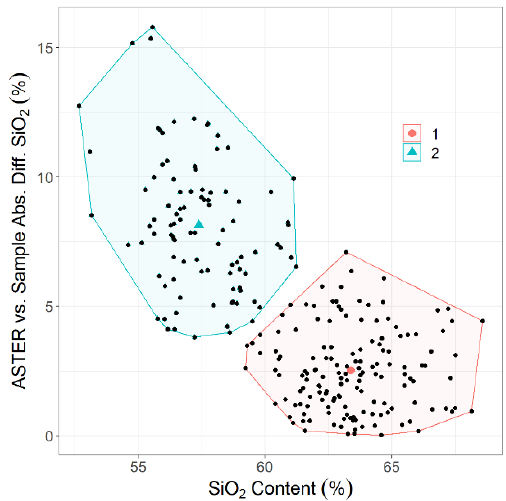
Figure 8. Absolute differences in silica content between ASTER and sample measurements as a function of silica content of the samples. Group 1 and group 2 from k-means clustering are indicated in red and blue boundaries, respectively. Center points of each group are shown in red circle and blue triangle for group 1 and group 2, respectively.